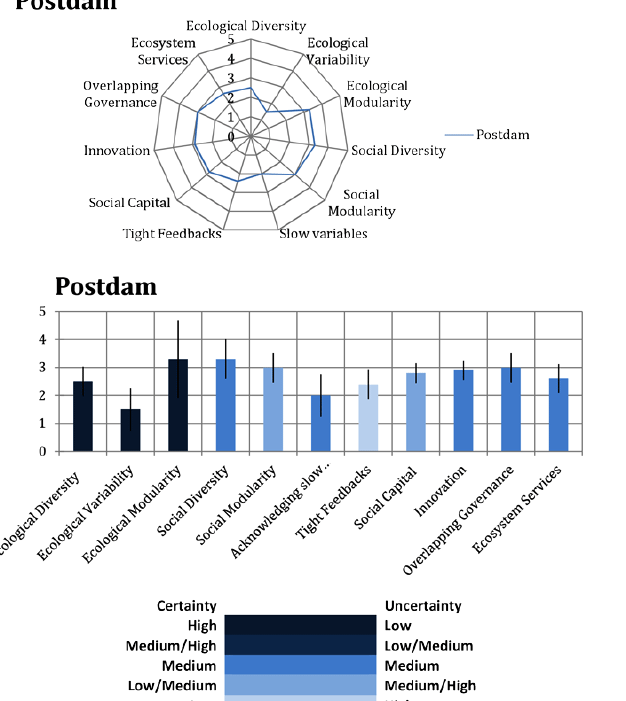
Fig. 4 . Resilience of the central Platte River social-ecological system in regard to Walker and Salt’s (2006) nine resilience properties and level of uncertainty associated with each property during the Platte River Recovery Implementation Program (PRRIP) time